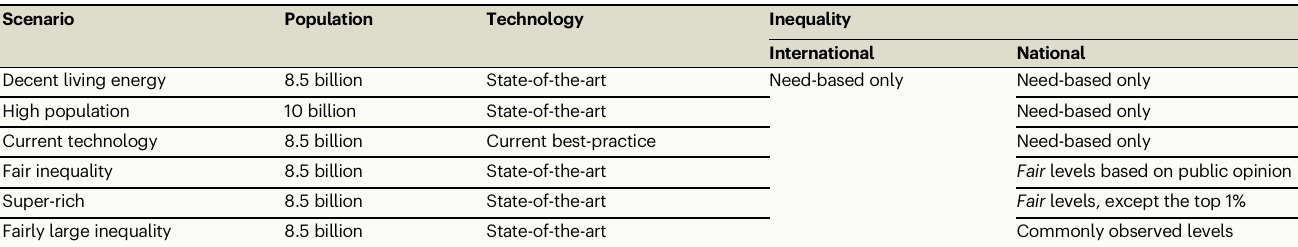
Table 2 | Summary of the key features of the six